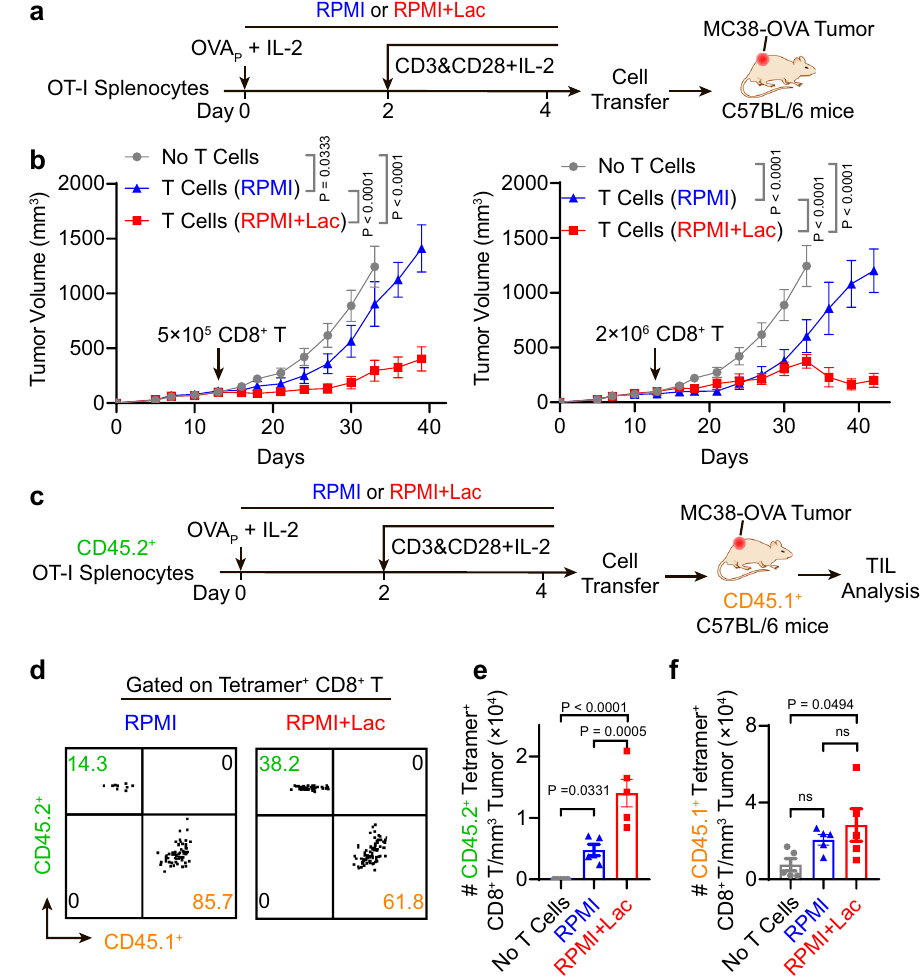
Fig. 7 |CD8 + T cellsexpanded under high lactateconditionshow potent tumor growth inhibition in vivo. a Treatment regimen of T cell receptor engineered T cell therapy (TCR-T). OT-I splenocytes were cultured ex vivo for 4 days with or without 40mM sodium lactate in the culture medium. After puri fi cation with negative selection magnetic beads, CD8 + T cells were transferred to MC38-OVA tumor bearing mice. Average tumor size is above 100mm 3 at the time of cell transfer. b The growth curves of MC38-OVA tumor model were signi fi cantly inhibited after transfer of TCR-T (5×10 5 or 2×10 6 ) pretreated with sodium lactate ( n =5). c Analysis of tumor-in fi ltrating T cells after adoptive TCR-T cell transfer.